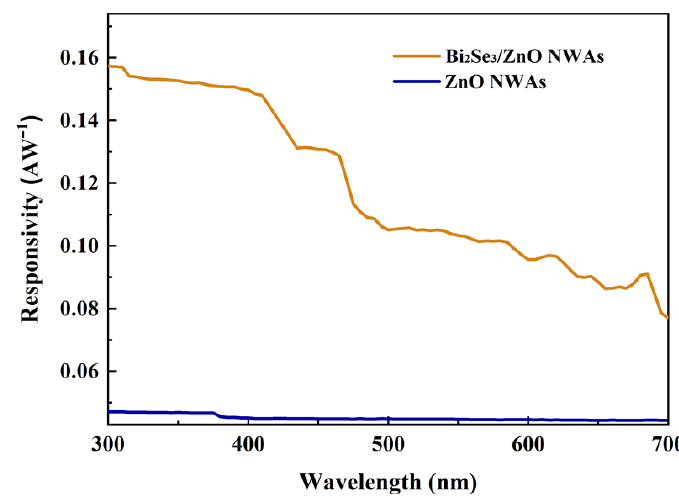
Figure 4. Responsivity spectrum of ZnO NWAs and Bi 2 Se 3 /ZnO NWAs photodetector.